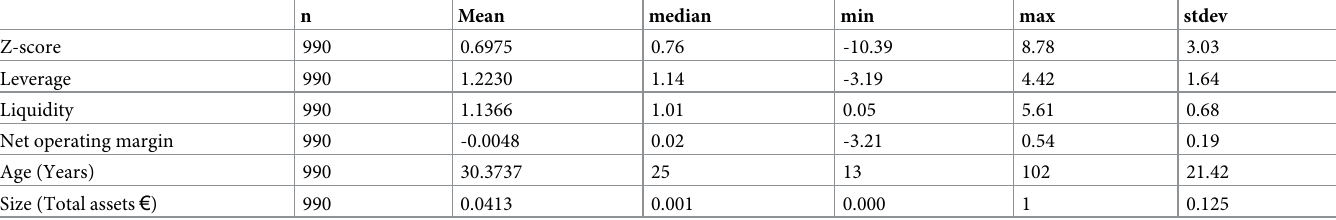
Table 2. Summary of descriptive